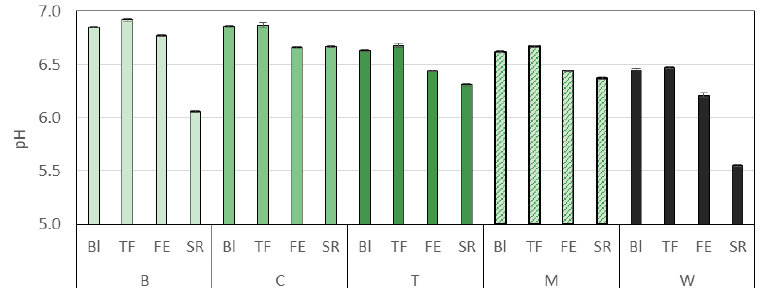
Figure 2. The pH values of suncream formulas in creams prepared with the thermal waters.